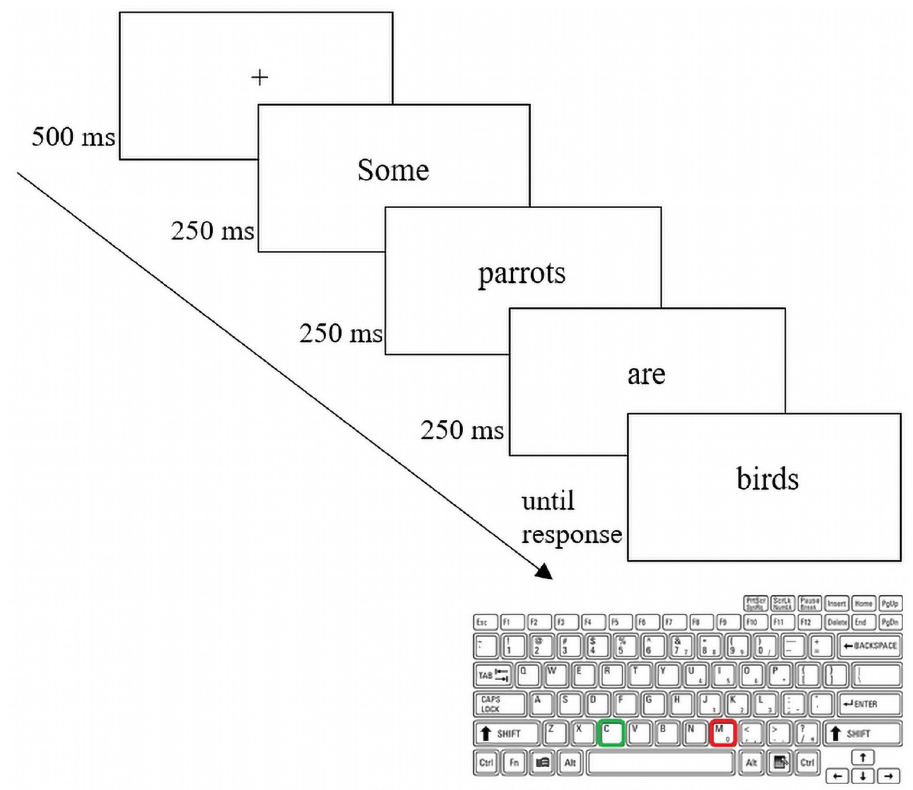
Fig 1. An example of the display of the test sentences including a fixation cross, series of words making up a categorical sentence, and a response keyboard.